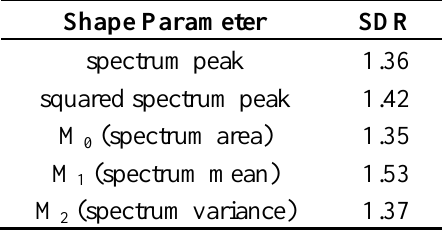
Table 1. Results of shape parameters evaluation by SDR criterion.